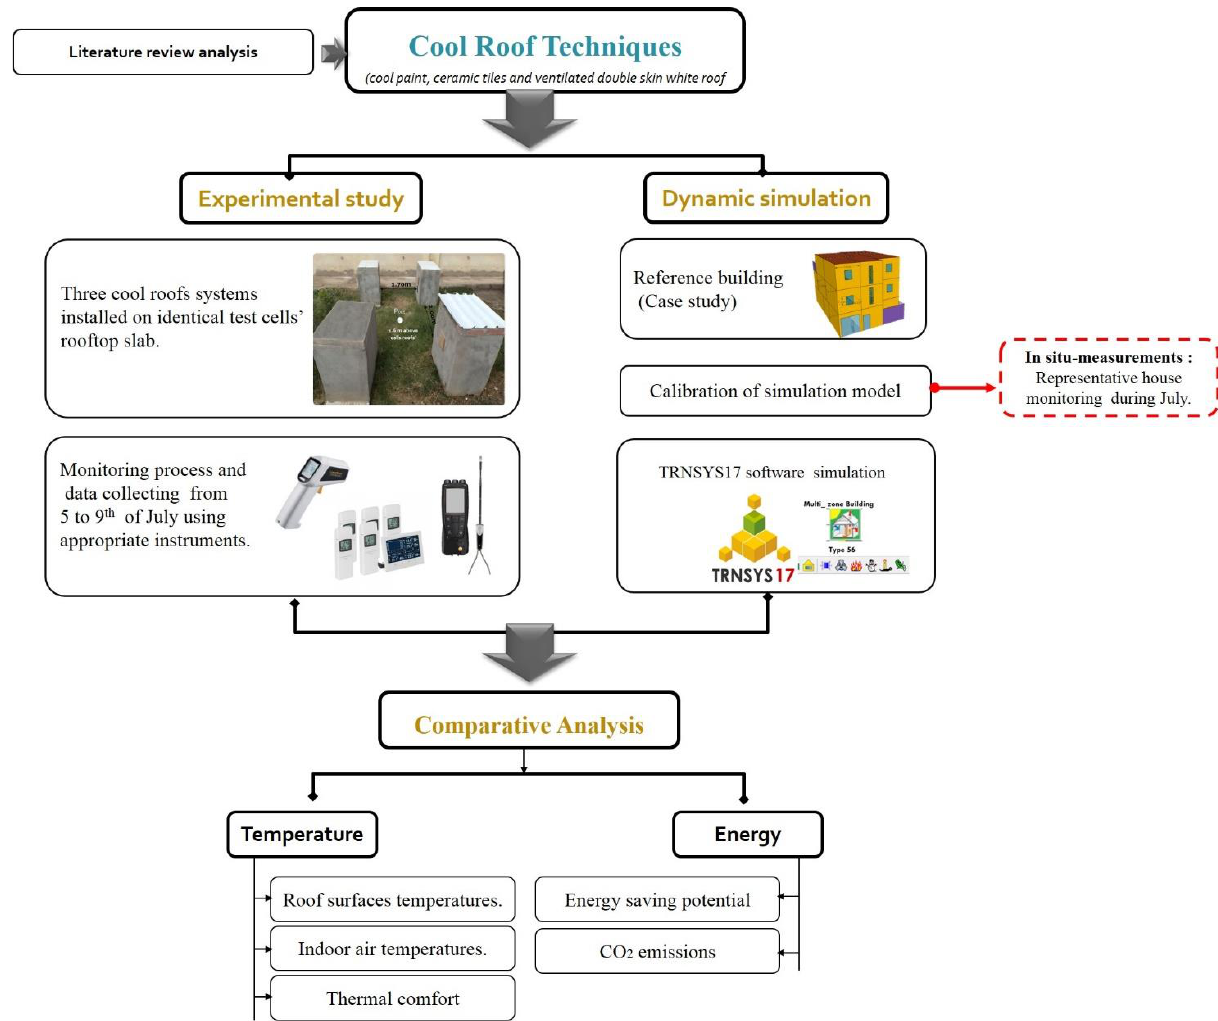
Figure 1. Research methodology workflow.